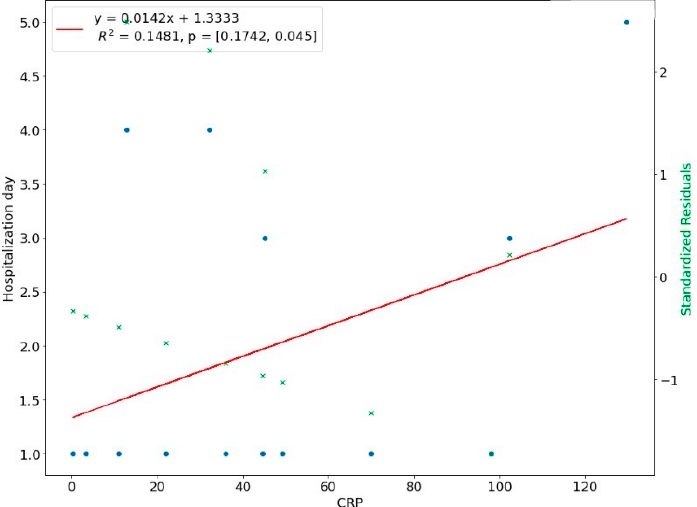
Figure 10. Correlation of NLR with length of hospital stay in lower face odontogenic infections.